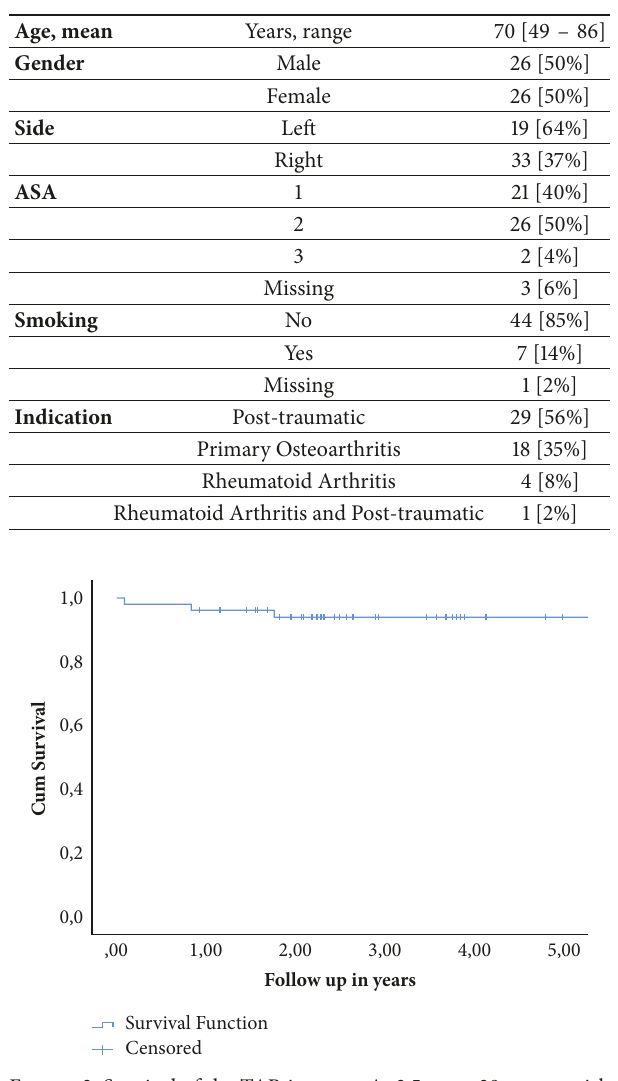
Table 1: Baseline characteristics.